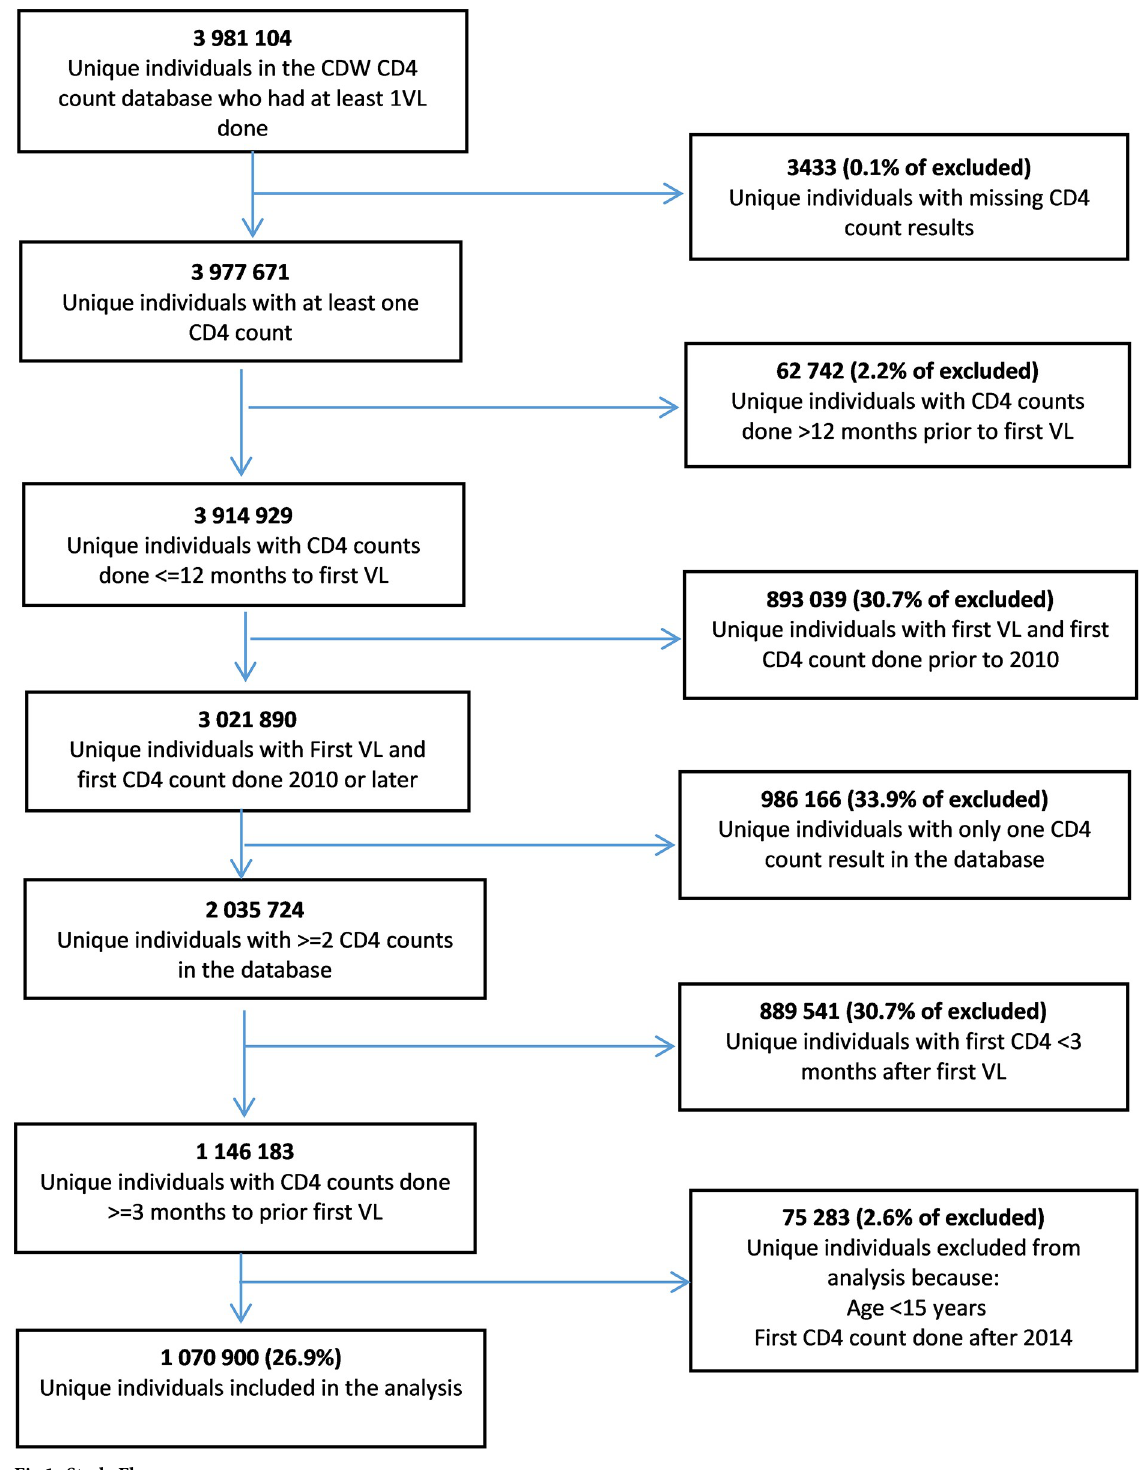
Fig 1. Study Flow.